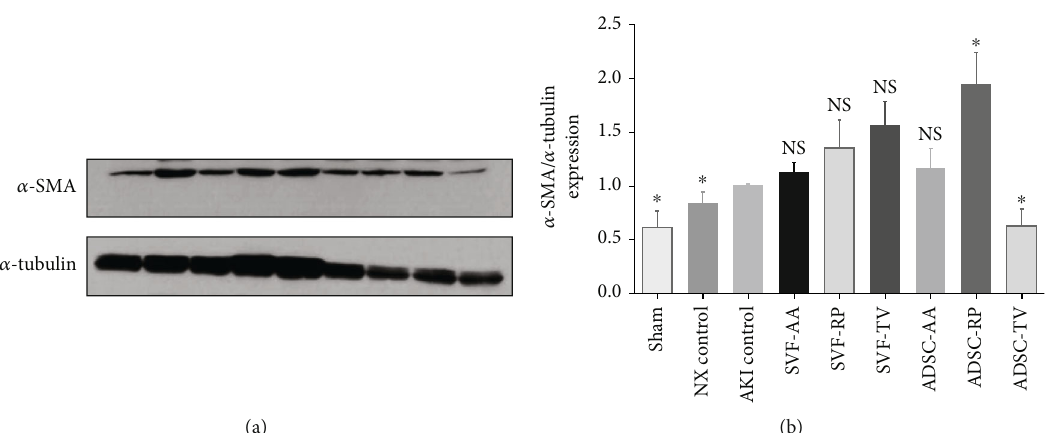
Figure 6: (a) Representative immunoblot bands of α -SMA expression in kidney tissue. (b) The graph showing protein levels as relative expression compared to the AKI control group. Relative quanti fi cation of protein levels was normalized for α -tubulin. NS, p > 0 : 05 ; ∗ p < 0 : 05 compared to the AKI control group. 3 timed per rat; 3 rats per